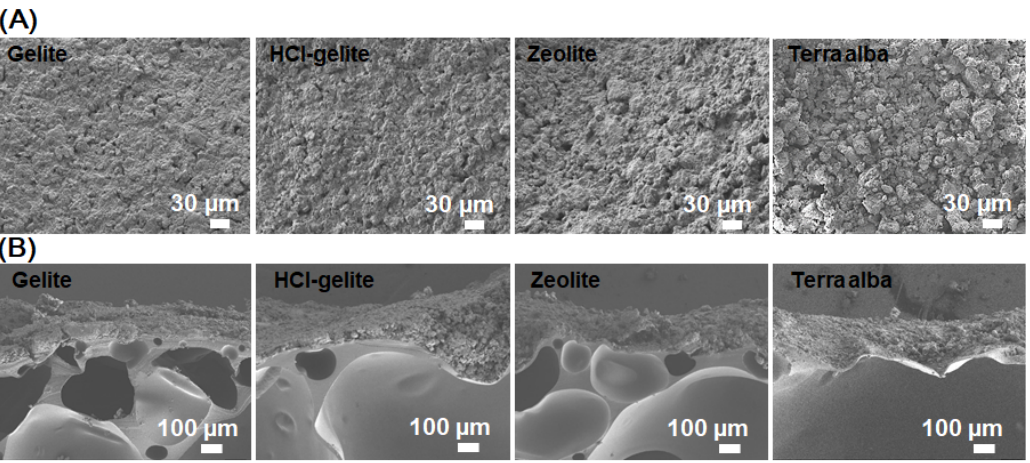
Figure 4. SEM images of the surface ( A ) and the cross section ( B ) of the complex foams after over-coated by the deodorant layers.